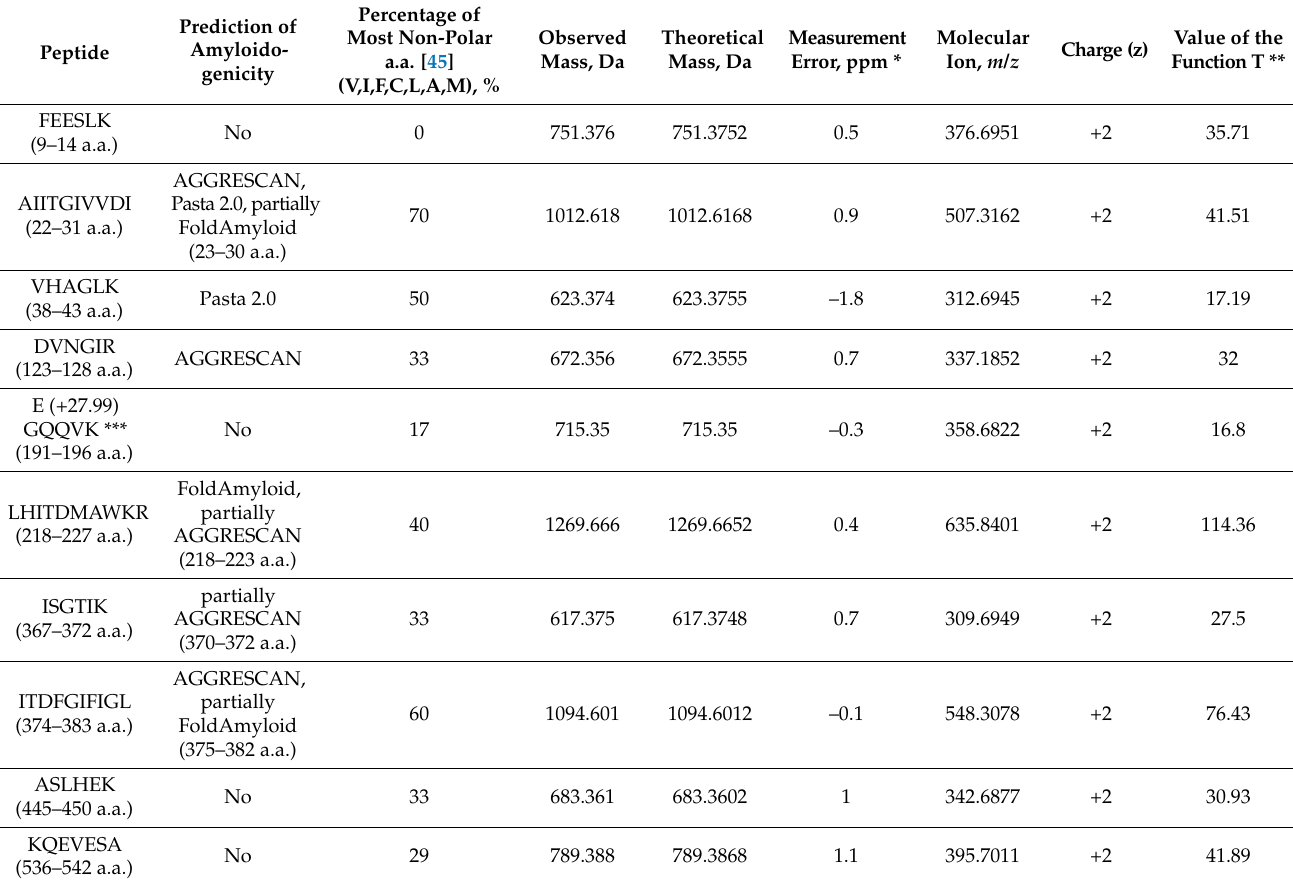
Table 1. Unique peptides identified as a result of comparing data from LC-MS analysis of hydrolysates of bPaS1 aggregates.